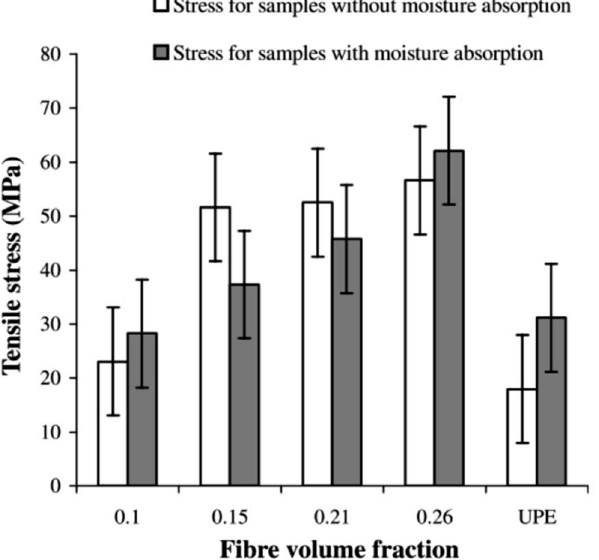
Figure 9. Moisture effect on the tensile strength of hemp/UP composites (reproduced from [56]).